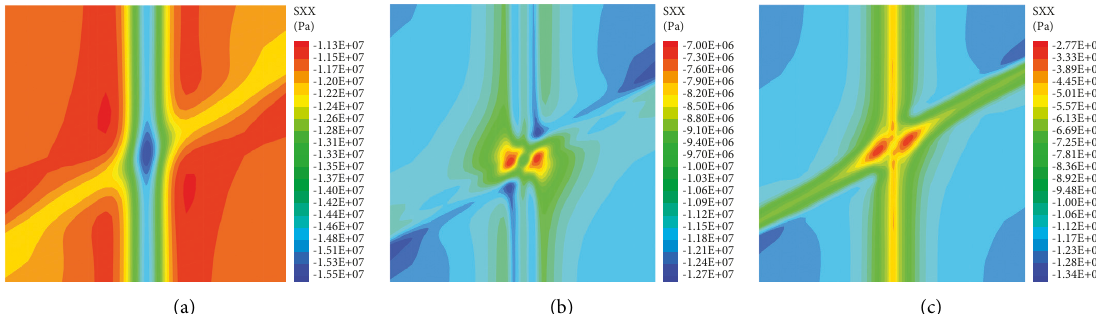
Figure 4: Disturbance influence of distance between roadways on surrounding rock horizontal stress of staggered roadway. (a) Distance between roadways 12m,(b) distance between roadways 6m, and (c) distance between roadways 2m.